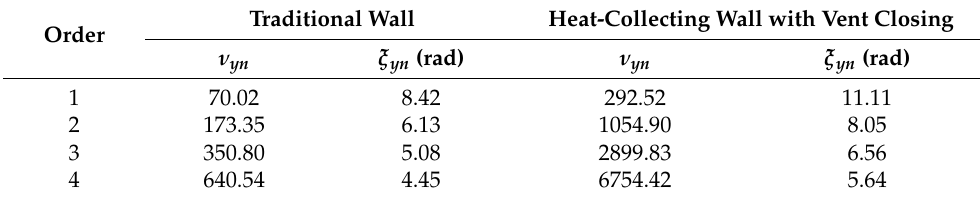
Table 7. Attenuation and delay calculation